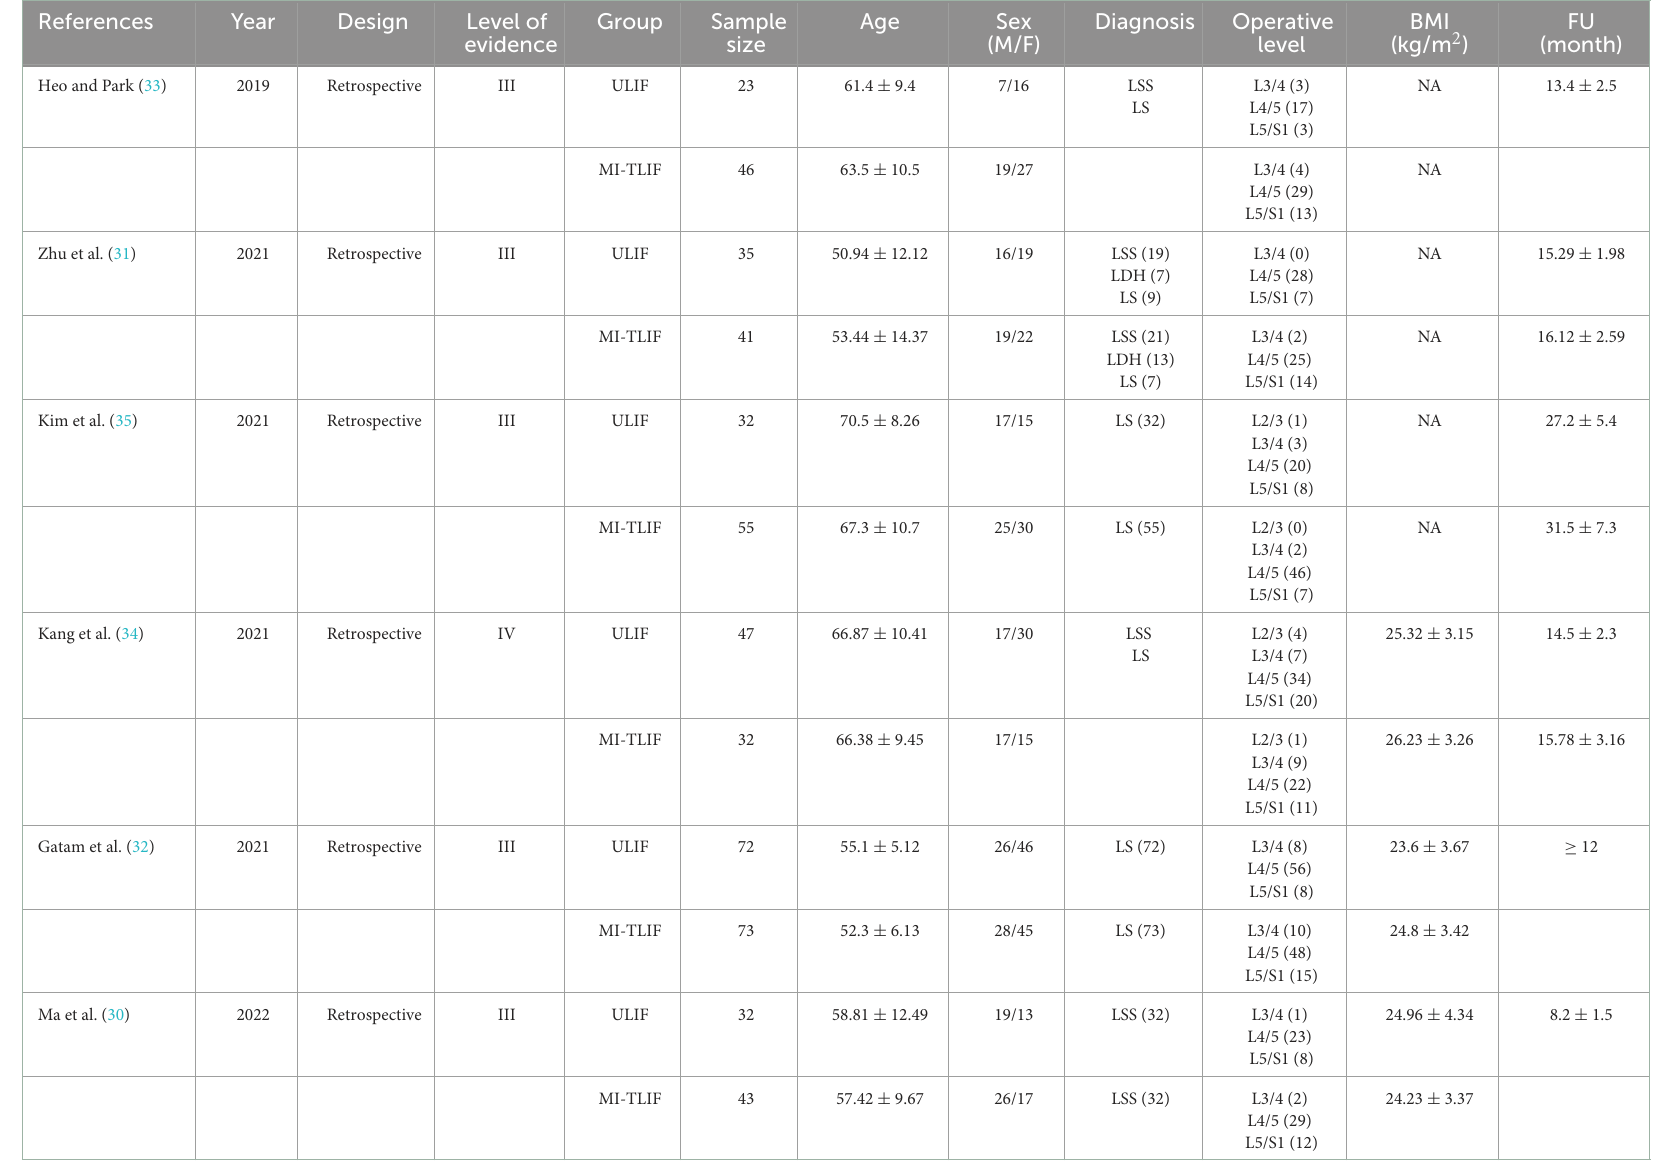
TABLE 2 Characteristics of the included